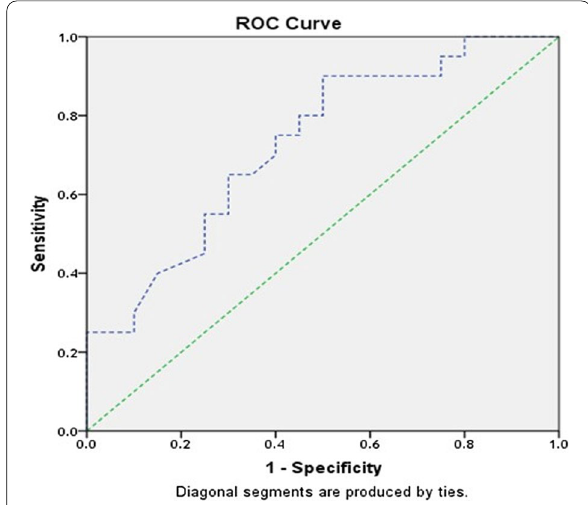
VE -VE Accuracy + predictive predictive Fig. 1 Receiver operating characteristics (ROC) curve for prediction of coronary artery disease. Significant area under the curve (0.729,